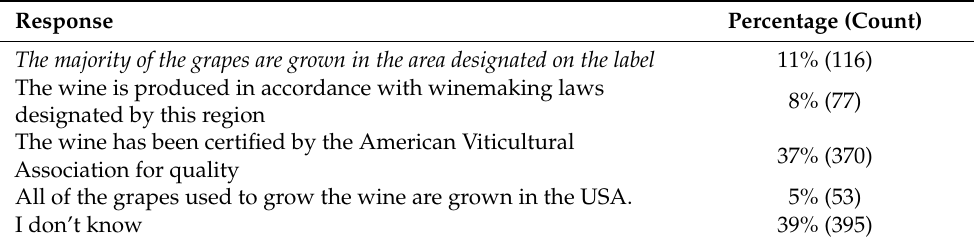
Table 5. Breakdown of 1011 participants’ responses to the question “What does AVA indicate when on a wine label?”. The italic answer is the correct